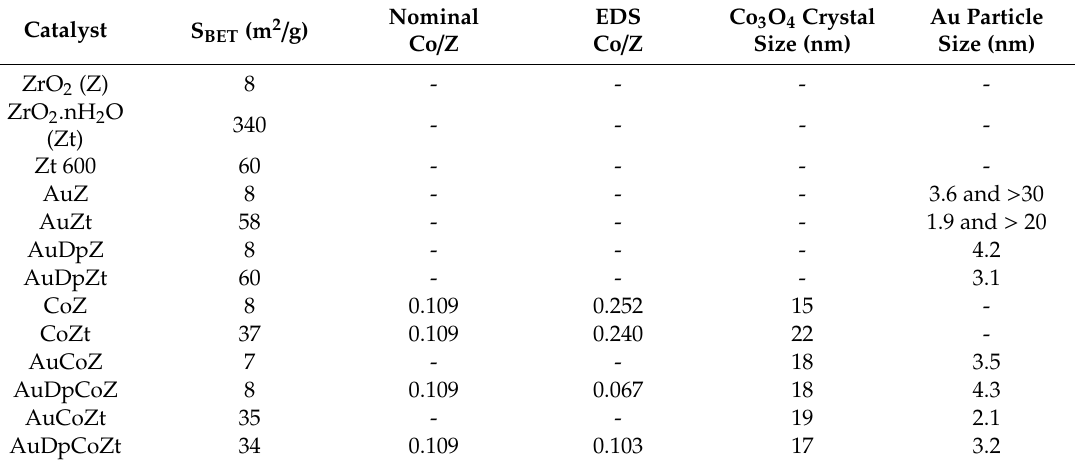
Table 1. Physicochemical properties of